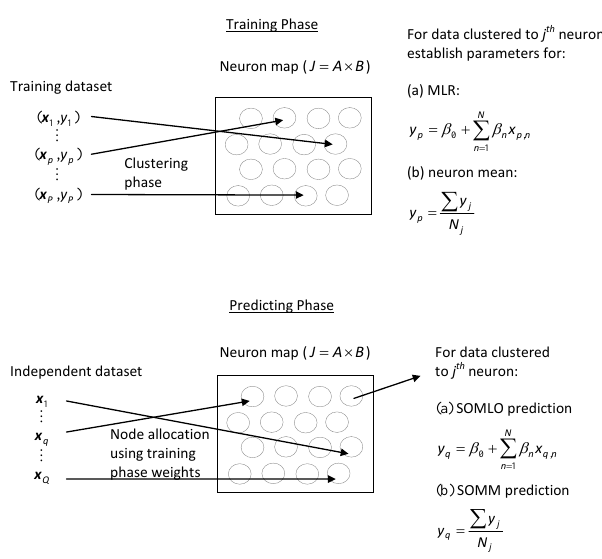
Fig. 4. Schematic diagram of neural network training and prediction